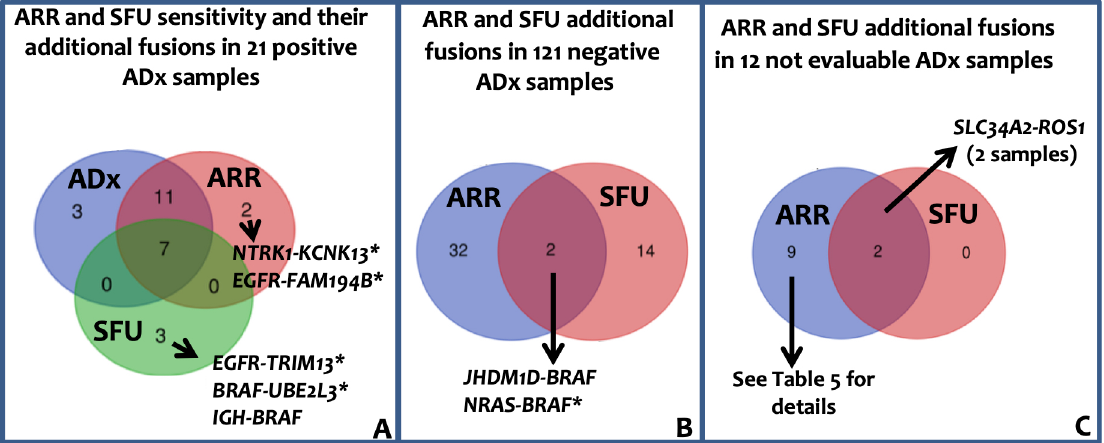
Figure 5. Lung panel: ARR and SFU results. A: Venn diagram showing ARR and SFU sensitivity. The sensitivity was evaluated assuming that the 21 fusions identified by ADx were true positive. Immunoglobulin heavy locus ( IGH )- BRAF gene fusion was recently reported in one patient with Hairy Cells Leukemia BRAF-V600E negative [29]. B: Venn diagram showing the additional fusion identified by ARR band SFU in the 121 negative ADx samples. C: Venn diagram representing the fusion called by ARR and SFU in the 12 ADx not evaluable samples. *: fusions unknown/unpublished; KCNK13 : potassium two pore domain channel subfamily K member 13; TRIM13 : tripartite motif containing 13; UBE2L3 : ubiquitin conjugating enzyme E2 L3; JHDM1D : jumonji C domain containing histone demethylase 1 homolog D; NRAS : NRAS proto-oncogene, GTPase; FAM194B : family with sequence similarity 194, member